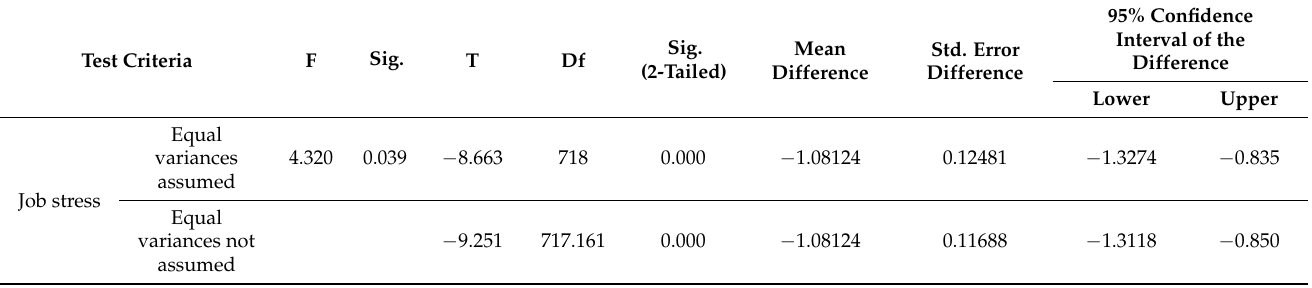
Table 7. The Levene’s test for the equality of variances and the t -test for the equality of